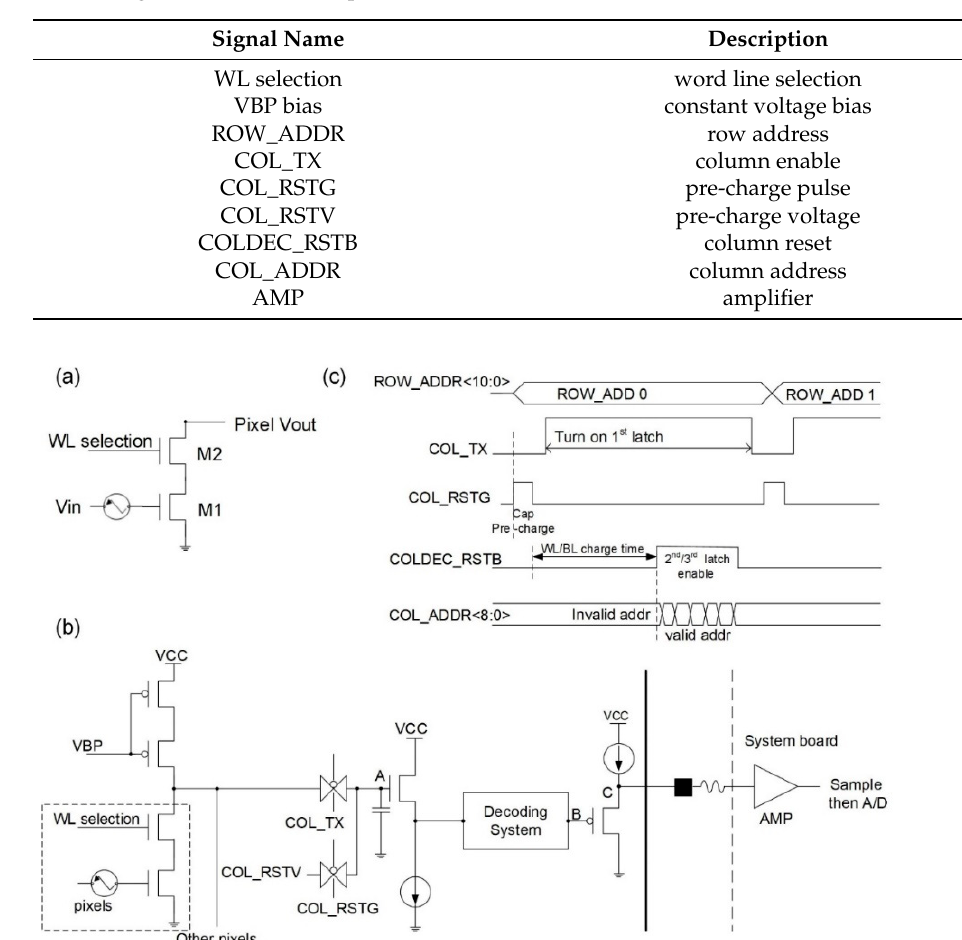
Table 1. Signal name and description.